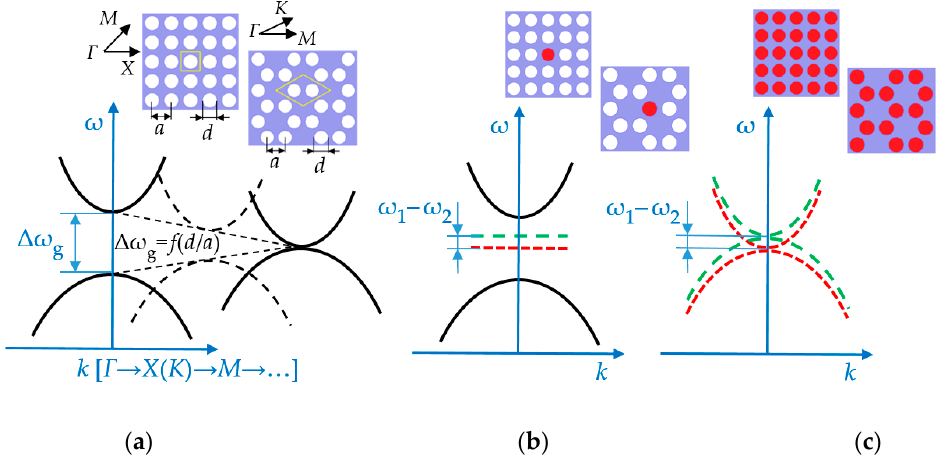
Figure 1. Basic approaches to design of phononic crystal based liquid sensor: ( a ) Schematic representation of the idea of a geometry defined bandgap width of phononic crystals based on two-dimensional arrangements of cubic or honeycomb symmetries; ( b ) an isolated liquid-filled hole point defect in a regular phononic crystal lattice; the liquid defect induces a band inside of broad bandgap phononic crystal; ( c ) periodic structure completely filled in with a liquid; here a narrow bandgap with a minimum or zero density of vibration states in the passband of overall structure is employed. Green and red (dotted lines) represent two different sound velocities of the liquid.